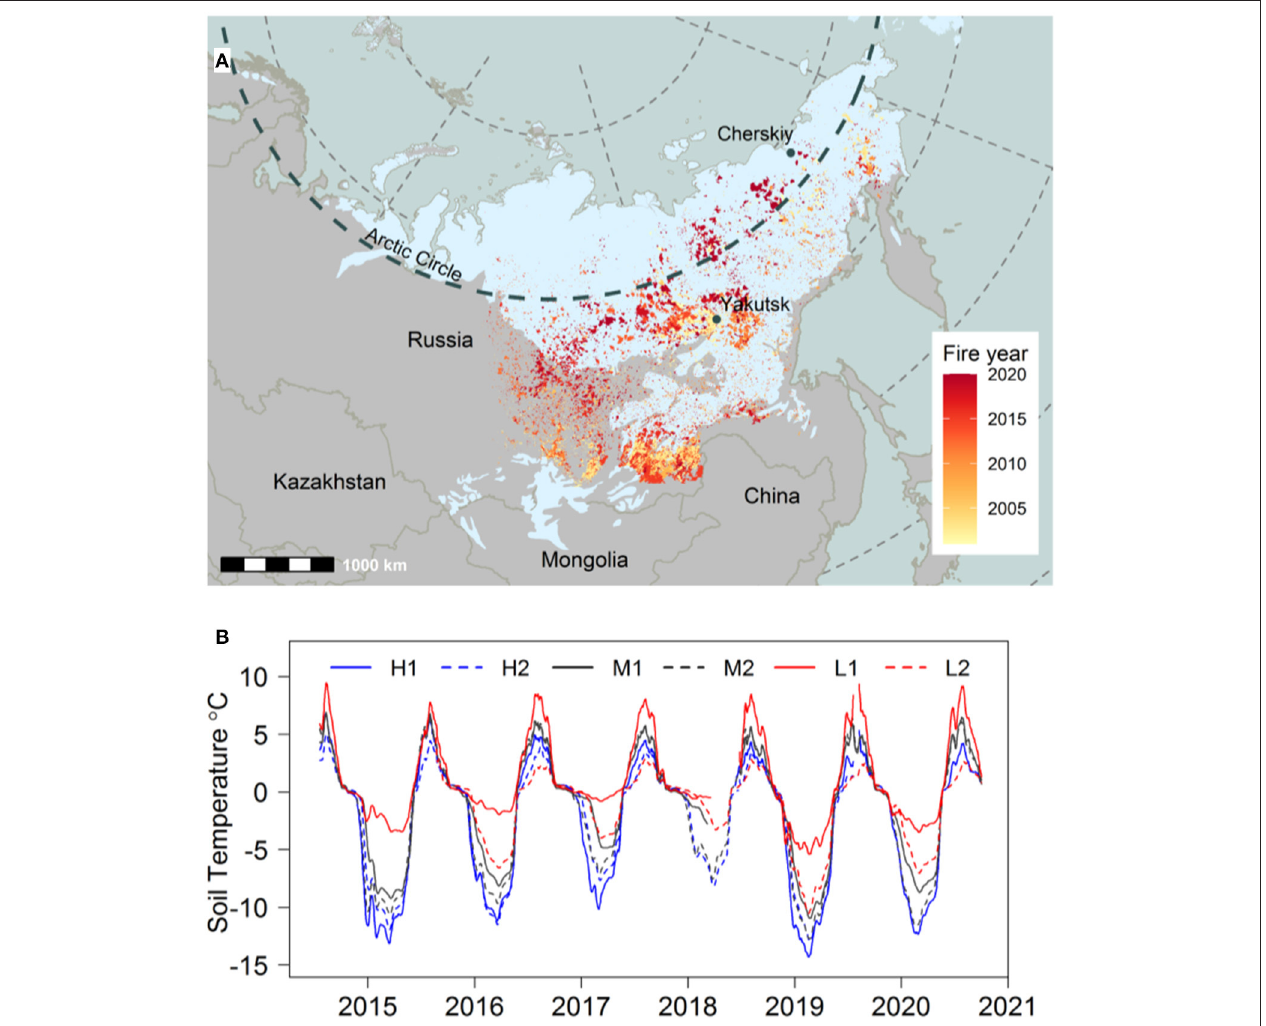
FIGURE 1 | Area burned (A) in eastern Siberia from 2001–2020 derived from Landsat data using Google Earth Engine (Talucci et al., 2021) with areas of continuous permafrost delineated in light blue. Note more area has burned (in red) in recent years above the Arctic circle (gray dashed line). Soil temperature (B) across a forest density gradient associated with post-fire regrowth within a burn perimeter near Cherskiy where H1 and H2 represent high-density stands ( > 75% canopy cover), M1 and M2 represent medium density stands (75% > canopy cover > 25%), and L1 and L2 represent low density stands ( < 25% canopy cover) ( Loranty and Alexander, 2021